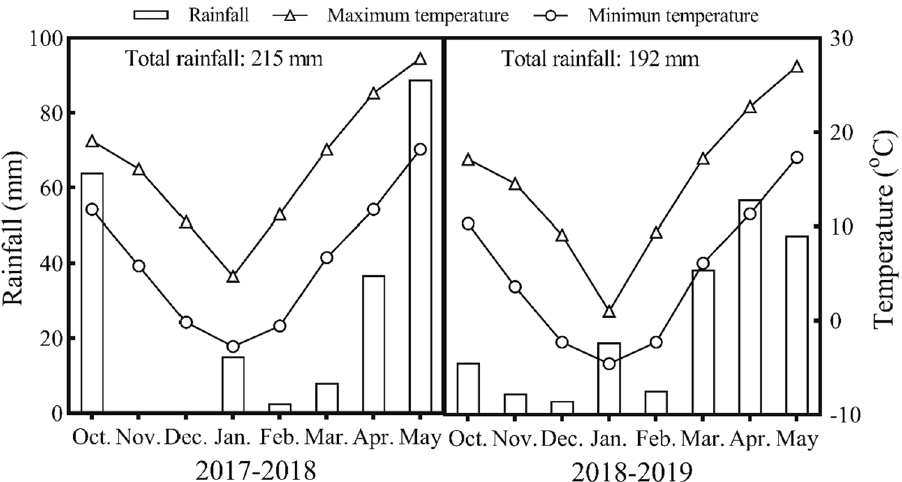
Figure 1. Monthly and annual rainfall and average maximum temperature and minimum temperature during the 2017/18 and 2018/19 wheat growing seasons at Xinxiang,